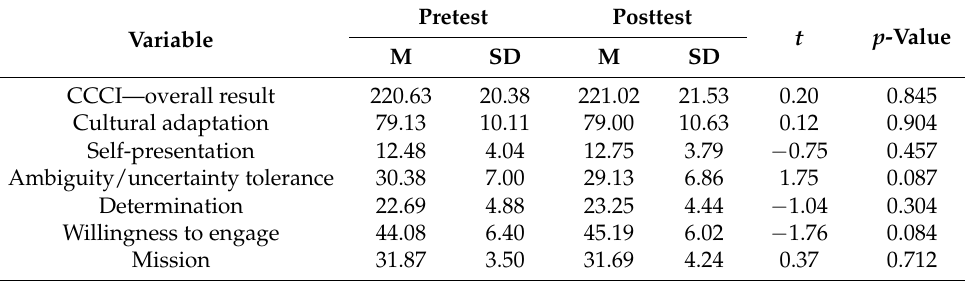
Table 4. Overall results of CCCI and subscales of nursing students in 2020 (study